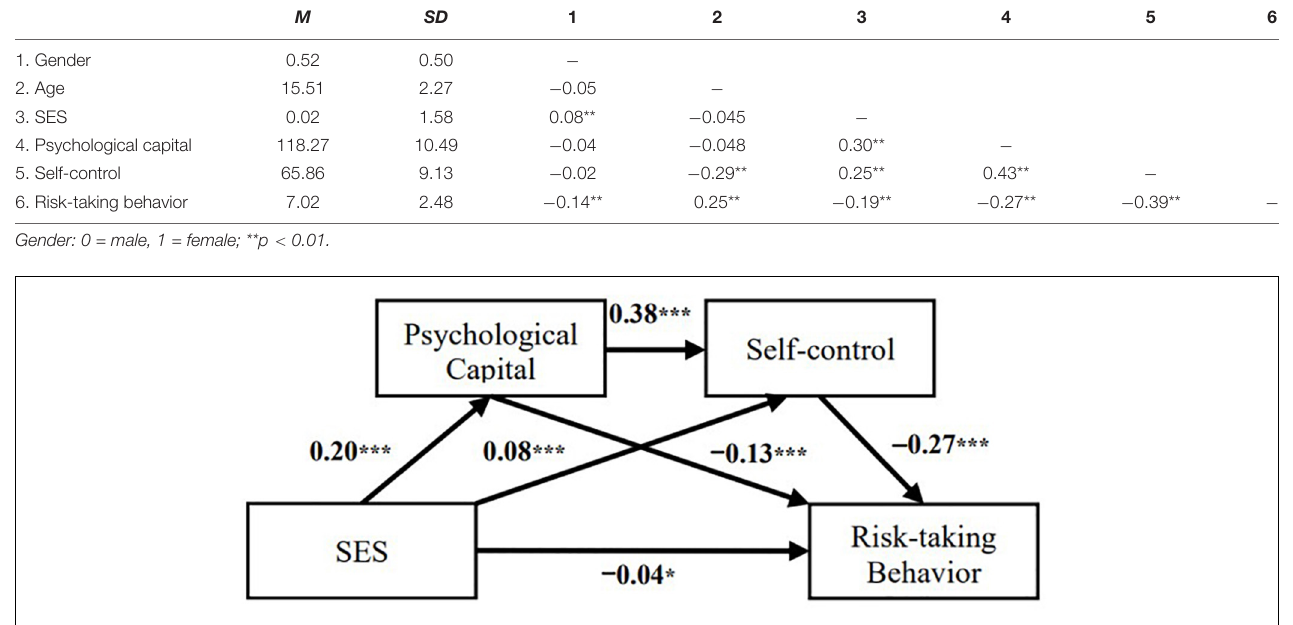
FIGURE 2 | Multiple mediation effect model. * p < 0.05 and *** p <